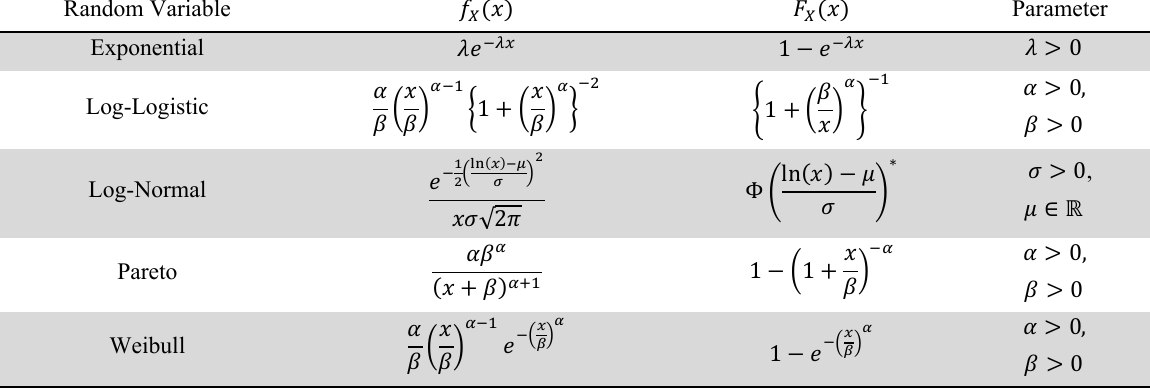
PDF and CDF of Exponential, Log-Logistic, Log-Normal, Pareto, and Weibull Random Variables Random